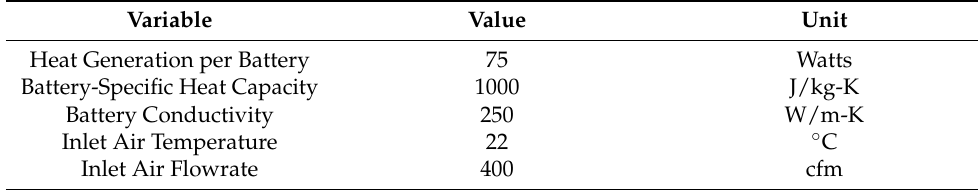
Table 3. Input variables used within full-scale model